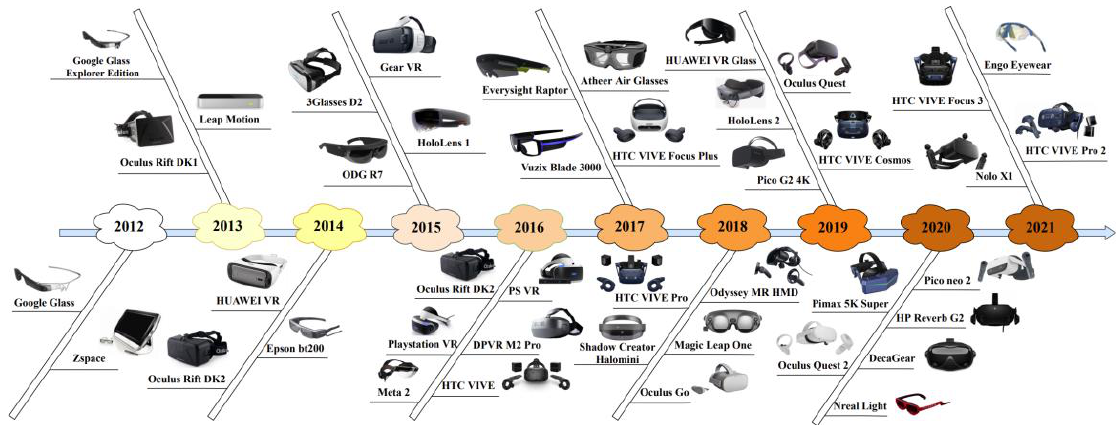
Figure 2. The emergence of the most used AR/VR HMDs in the past ten years.